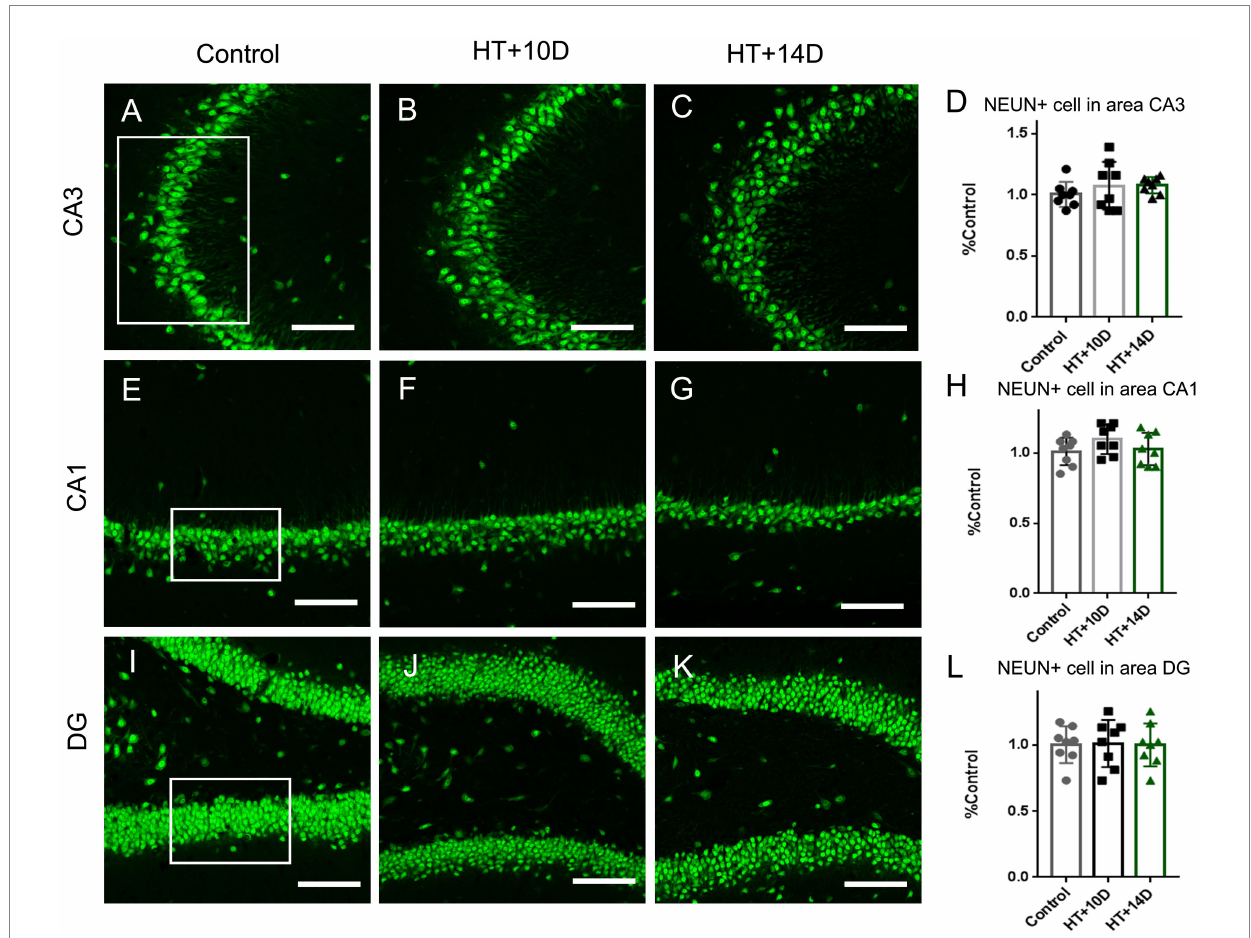
FIGURE 1 The number of NEUN positive neurons in subregions of hippocampus is unaltered after experimental febrile seizures. Scale bars: 100 μ m. Compared with the control group, there is no remarkable change in the number of pyramidal neurons in subregion of CA3 (A–D) and CA1 (E–H) , as well as the granule cells in DG (I–L) after experimental febrile seizures in both HT + 10D and HT + 14D groups ( n = 8 per